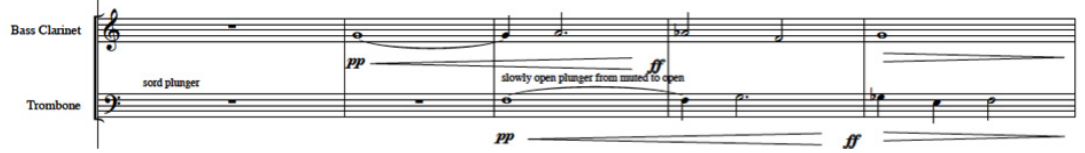
Figure 4. Exposition of the theme in traditional notation.